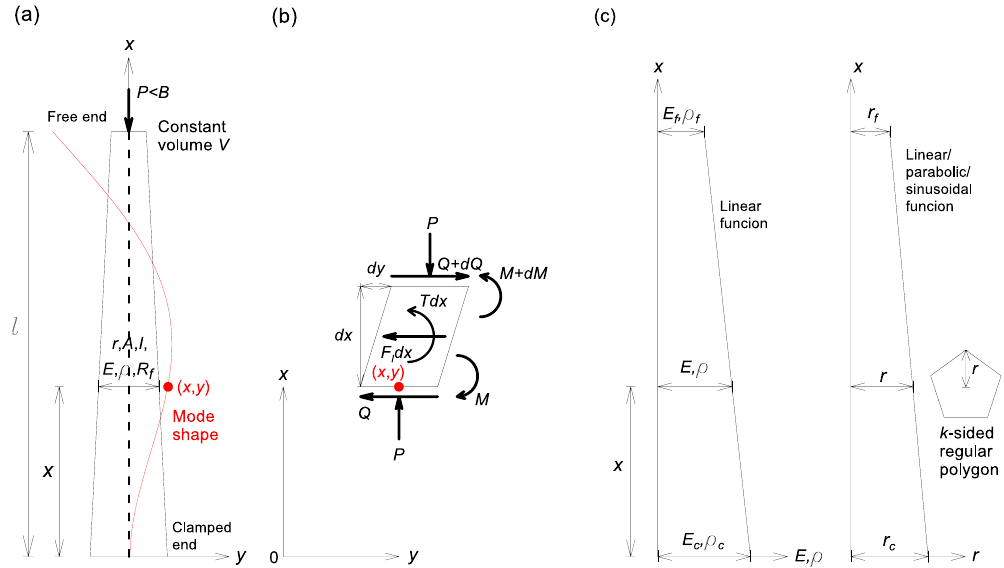
Figure 1. ( a ) Schematic view of an axially functionally graded (AFG) cantilever column with constant volume; ( b ) free body diagram of the column element; ( c ) variations of Young’s modulus (and mass density) and circumradius of the regular polygon.